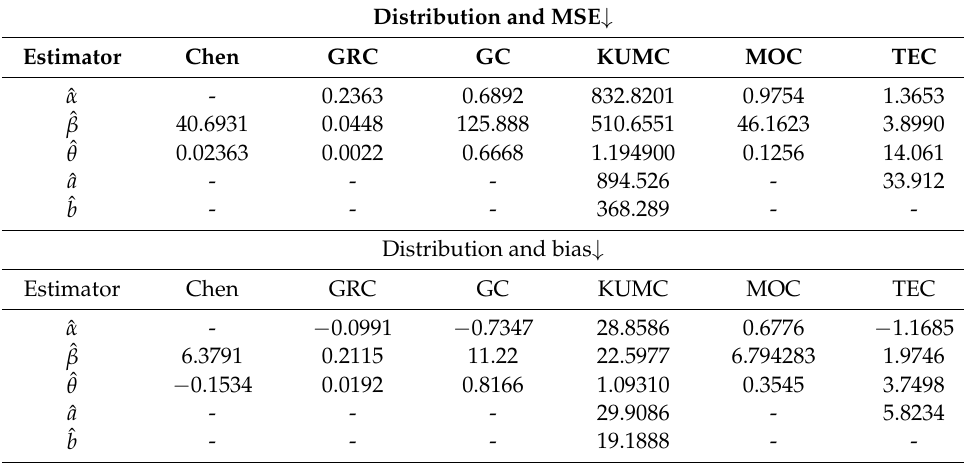
Table 13. Results for samples generated from the GRC distribution with n = 50.